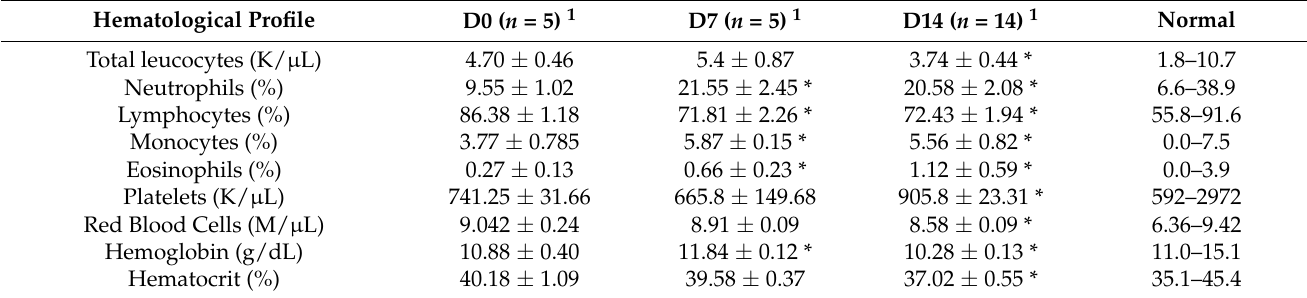
Table 2. Hematological Profile of Treated and Control